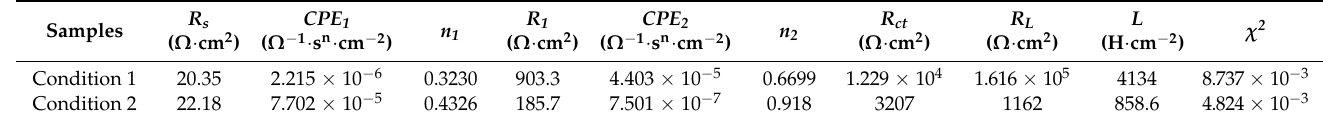
Figure 6. Impedance spectra of the coatings in conditions 1 and 2: ( a ) Nyquist images. ( b ) Bode plots of |Z| vs. frequency. ( c ) Bode plots of phase angle vs. frequency. ( d ) Fitting circuit image. Table 5. Electrochemical data for the coatings in conditions 1 and 2, obtained via equivalent circuit fitting of EIS